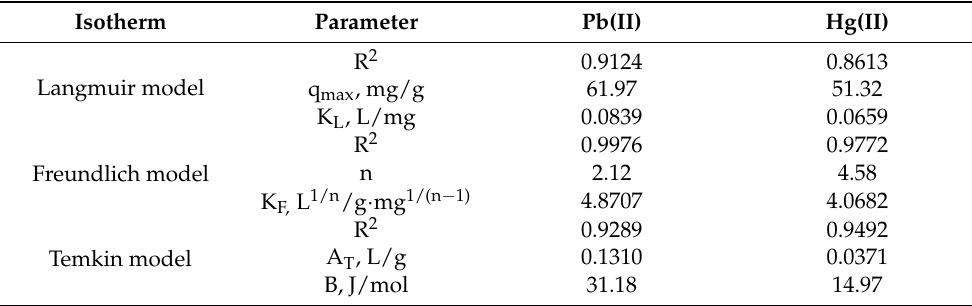
Table 3. Isotherm parameters for the biosorption of Pb(II) and Hg(II) ions on RWB biosorbent. Isotherm